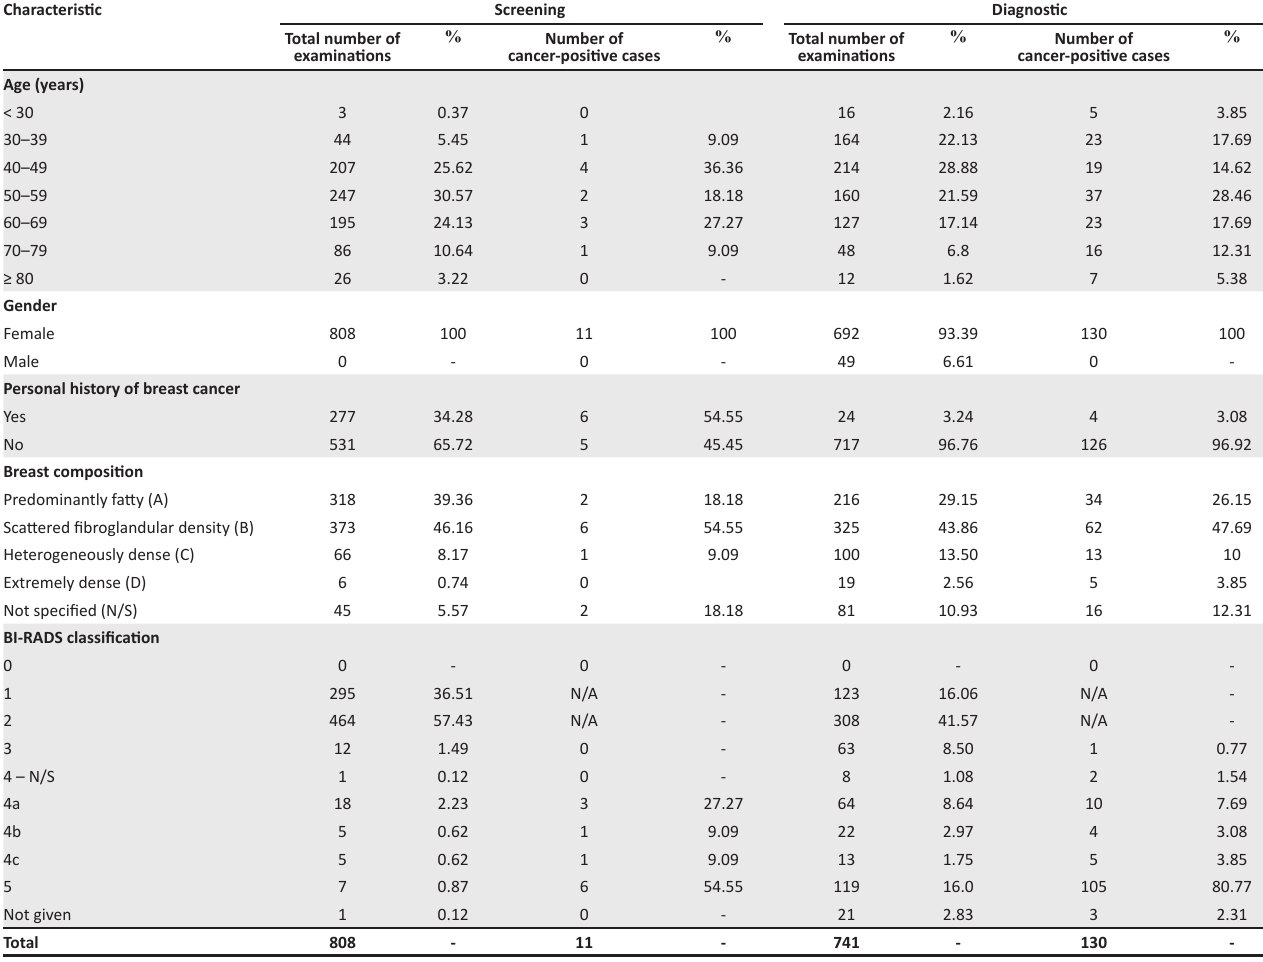
TABLE 3: Audit results for 1549 mammography examinations. Characteristic Screening